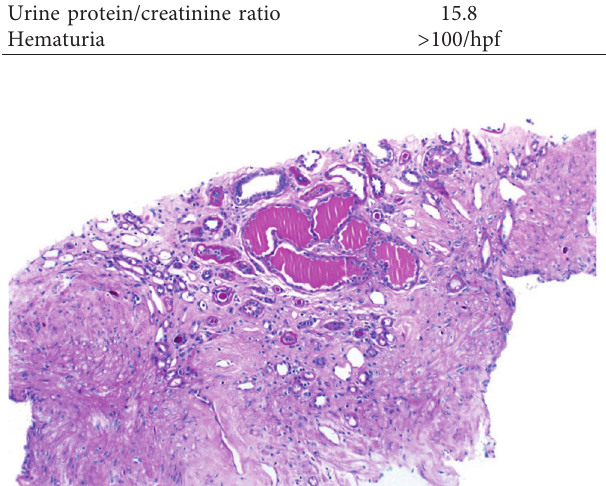
Figure 1: Focal microcystic tubular dilatation.